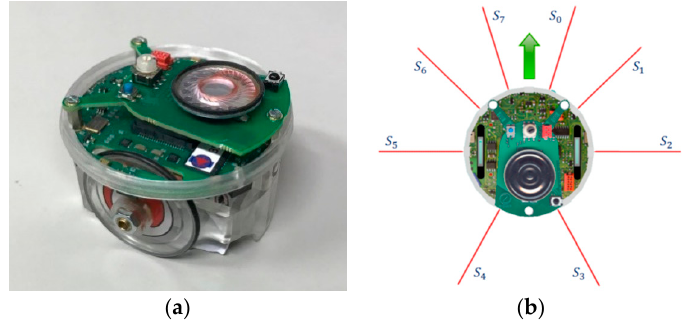
Figure 1. E-puck mobile robot architecture ( a ) E-puck mobile robot, ( b ) Infrared sensor position.